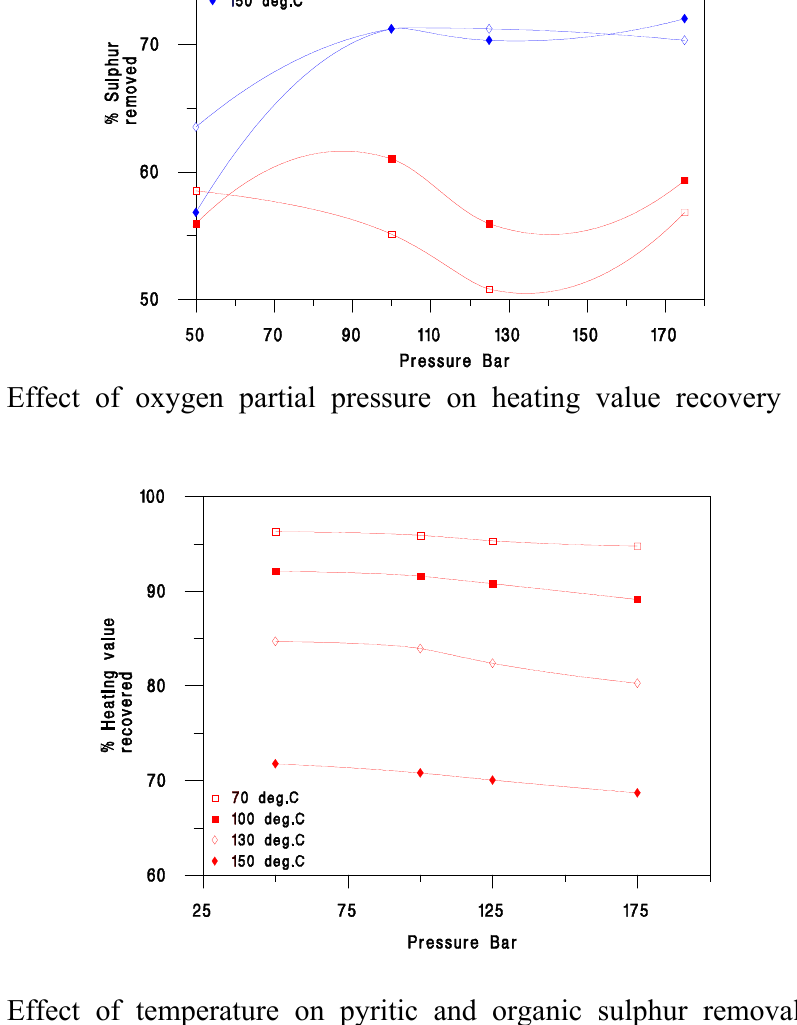
Figure 14. Effect of temperature on pyritic and organic sulphur removal at constant oxygen pressure for Prince of Wales